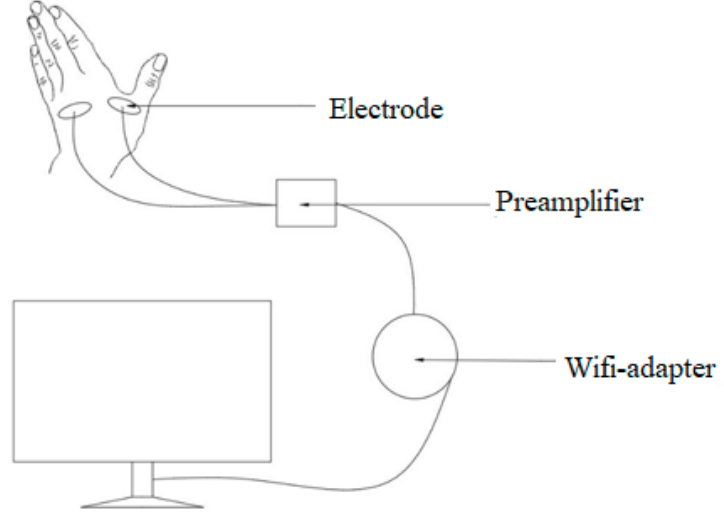
Figure 3. The model of muscle tension recording with terms of the surface electromyography (sEMG) system.